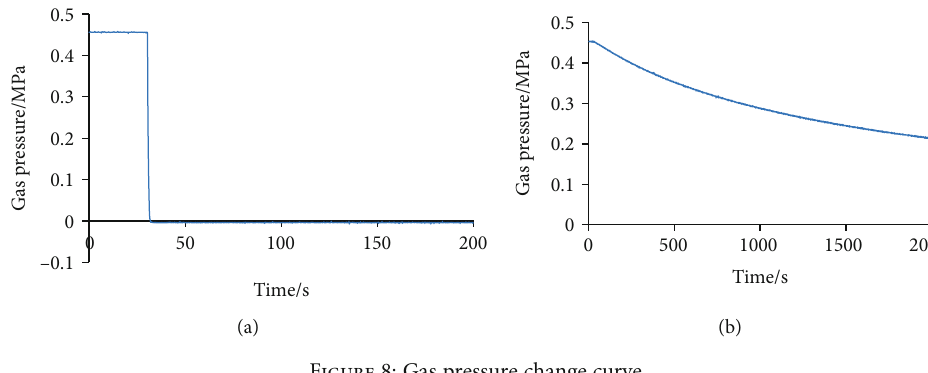
Figure 8: Gas pressure change curve.